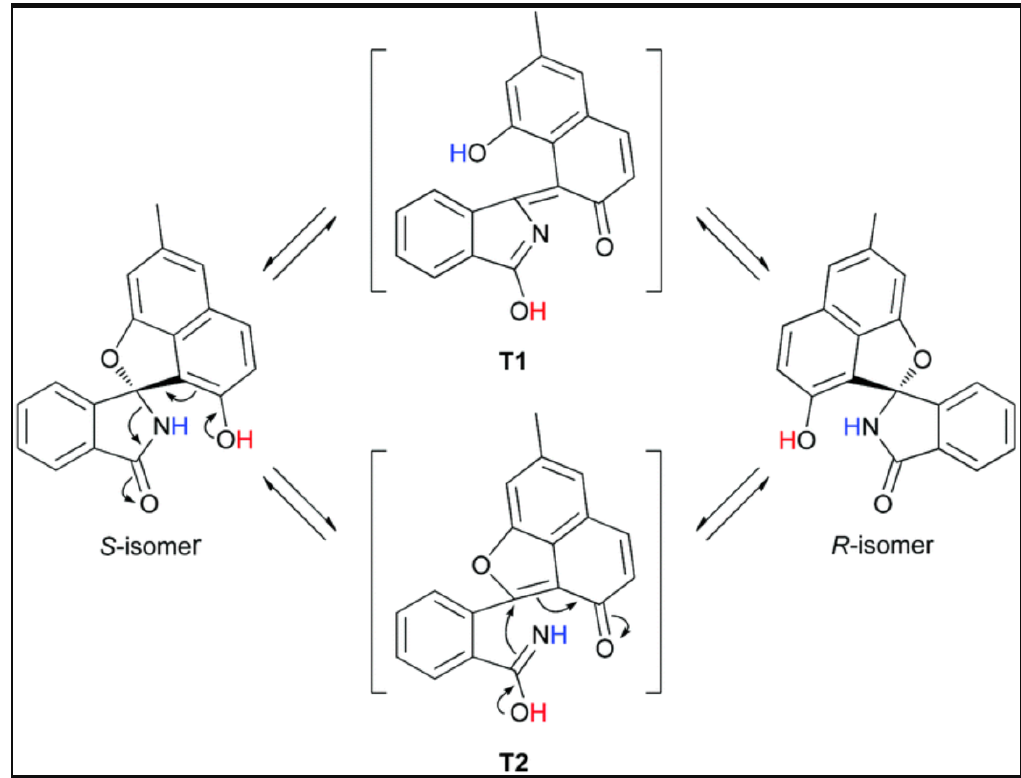
Figure 23. Conversion of a + to − form of pratensilins A due to tautomerization. Taken from Ref. [96], with permission from the Royal Society of Chemistry.